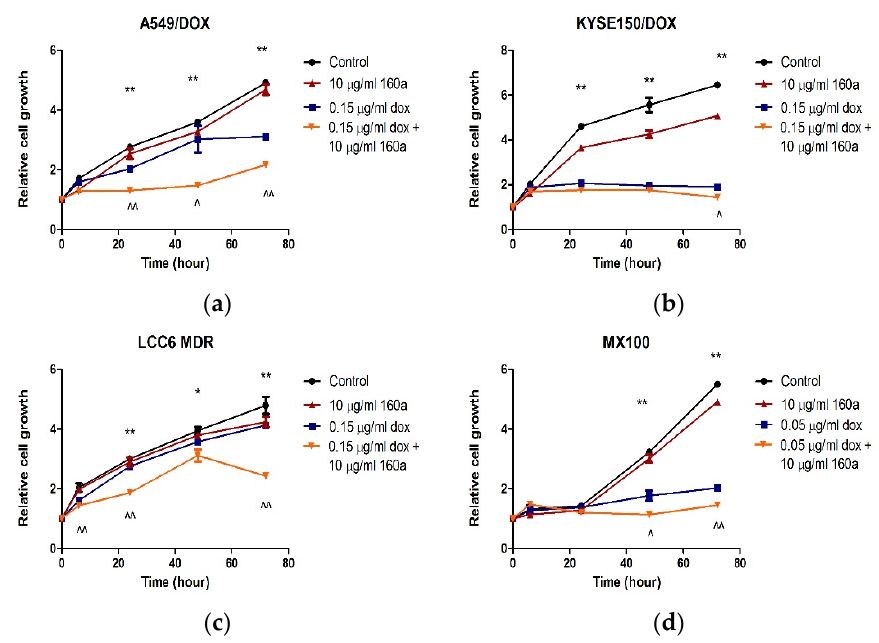
Figure 4. Cell proliferation curves of doxorubicin-resistant cells co-cultured with compound 160a, doxorubicin, and compound 160a combined with doxorubicin. ( a ) A549/DOX cells; ( b ) KYSE150/DOX cells; ( c ) LCC6/MDR cells; ( d ) MX100 cells. DMSO (0.1%) was applied as a vehicle control . n = 3. * p < 0.05, ** p < 0.01 comparing the doxorubicin combined with compound 160a group with the control group; ^ p < 0.05, ^^ p < 0.01 comparing the doxorubicin combined with compound 160a groups with